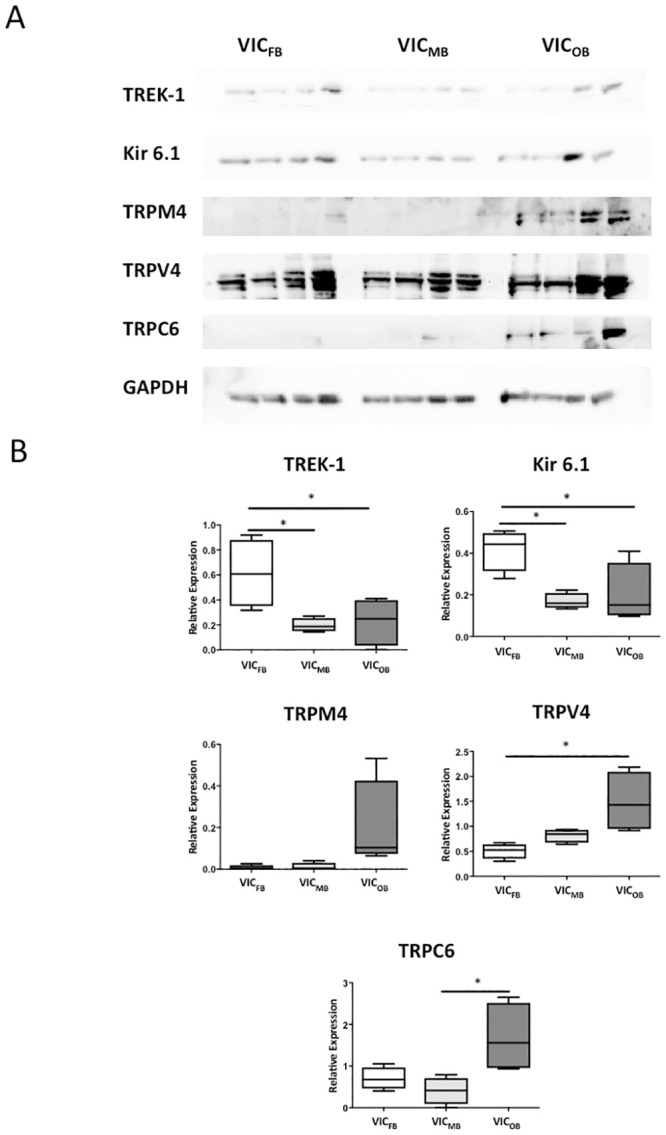
Protein levels of mechanosensitive ion channels in phenotypically different VIC populations.A: Western blots showing expression of MSC in cultures of VICFB, VICMB, and VICOB. B: Quantification of relative expression of individual channel proteins in cells of each phenotype, normalized to GAPDH levels (n = 4 patients; * = p<0.05).